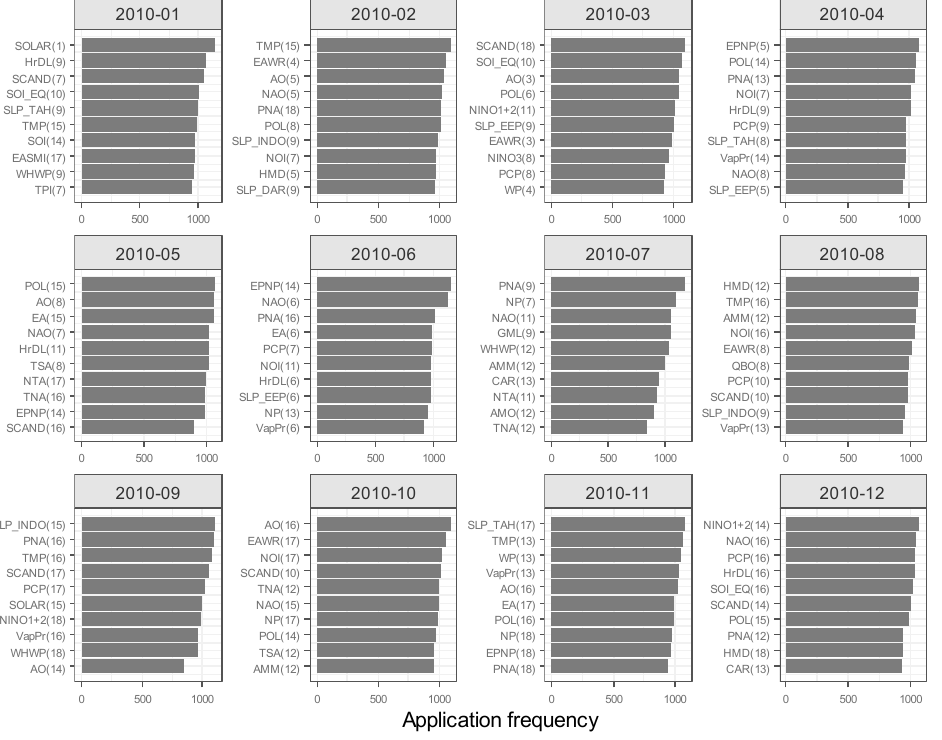
Figure 6. Application frequency of the climate indices used for monthly precipitation forecasting in 2010.